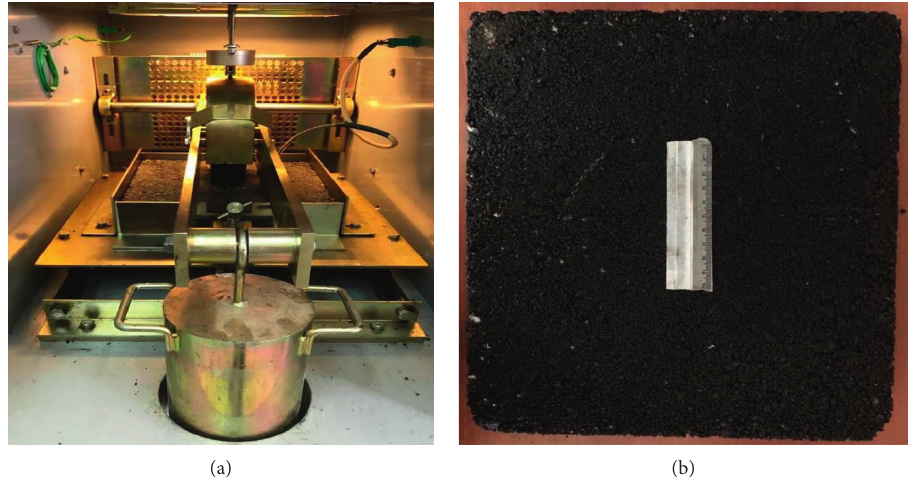
Figure 5: Wheel-tracking test: (a) wheel-tracking test apparatus and (b) manufactured slab of asphalt